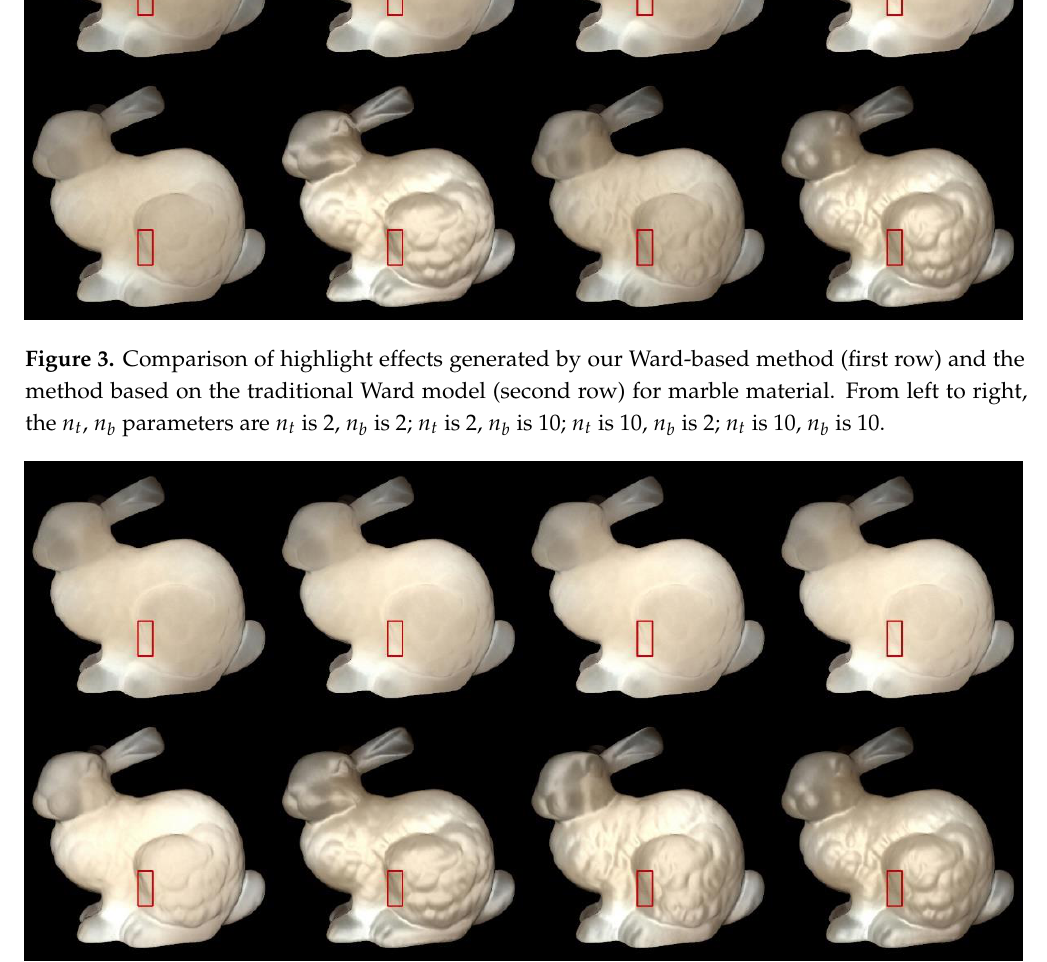
Figure 4. Comparison of highlight effects generated by our Ashikhmin-based method (first row) and the method based on the traditional Ashikhmin model (second row) for marble material. From left to right, the n t , n b parameters are n t is 2, n b is 2; n t is 2, n b is 10; n t is 10, n b is 2; n t is 10, n b is 10.